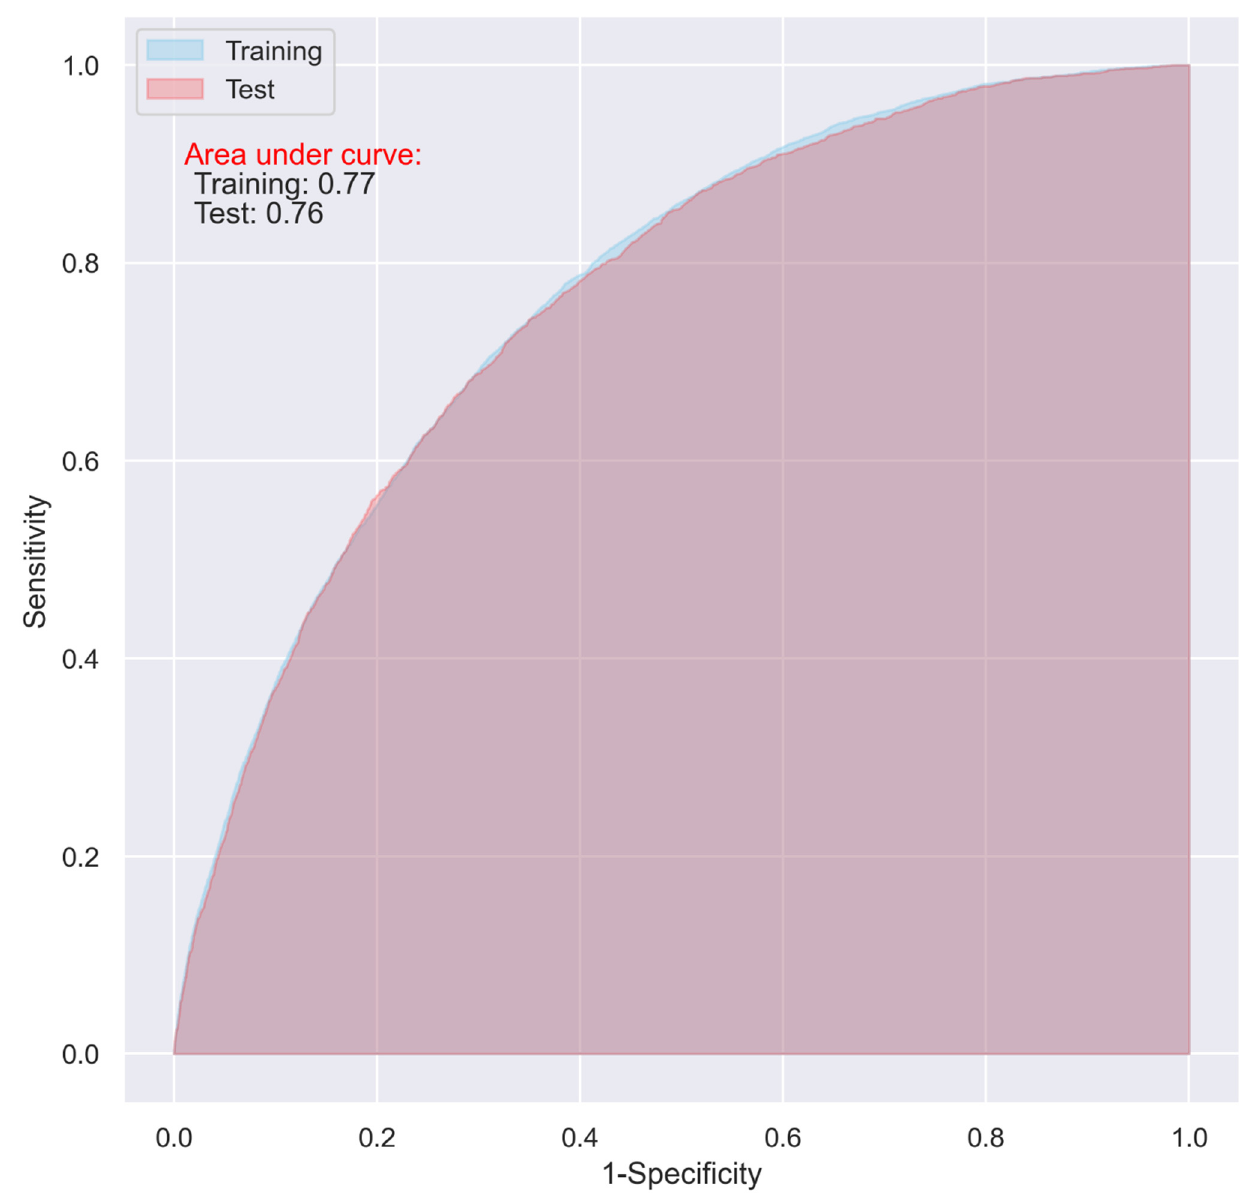
Figure 6. ROC of the LR model including the variables with a relative importance of >0.05 in the stepwised LR model.